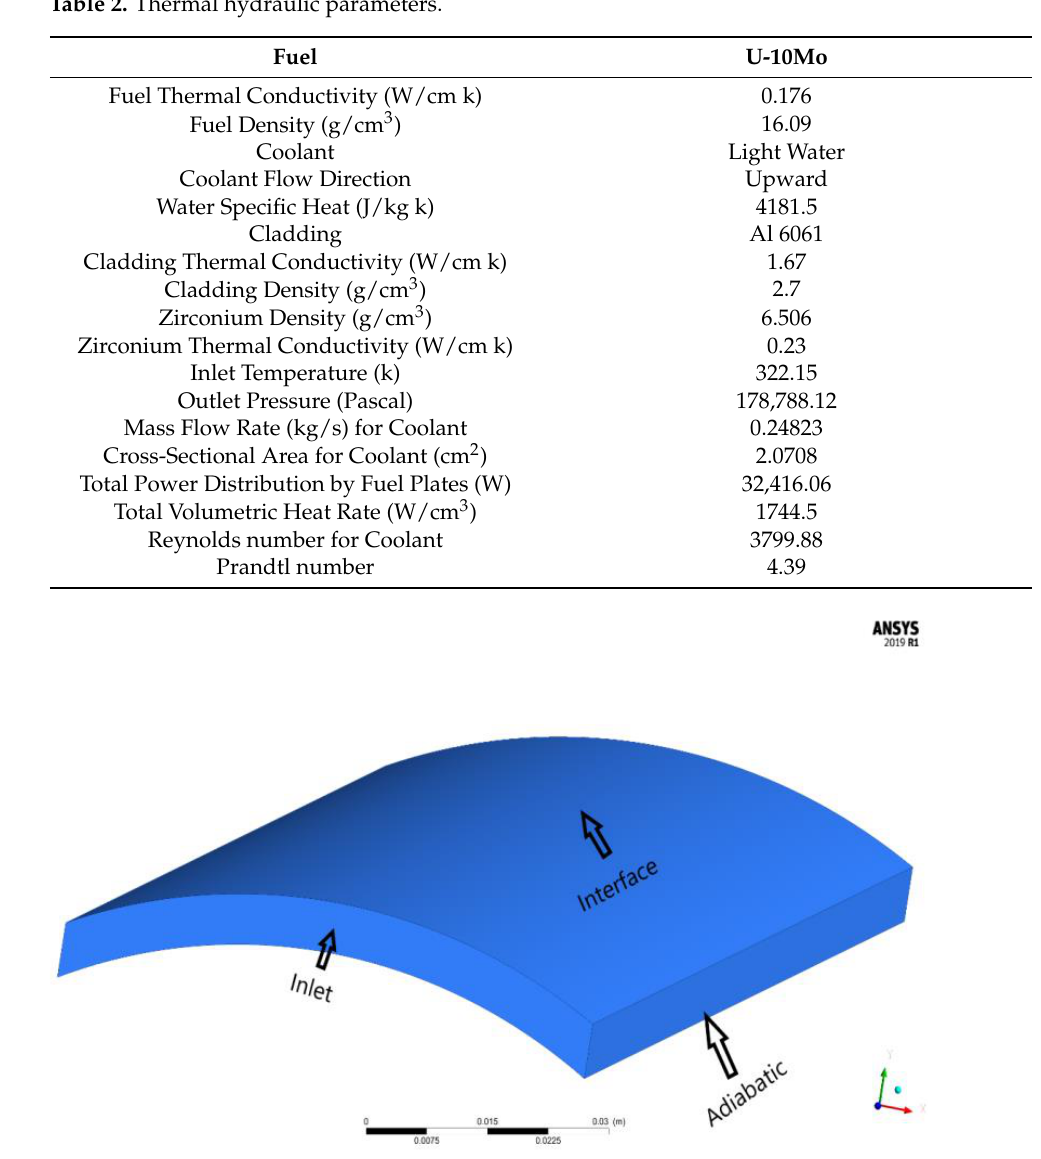
Table 2. Thermal hydraulic parameters.